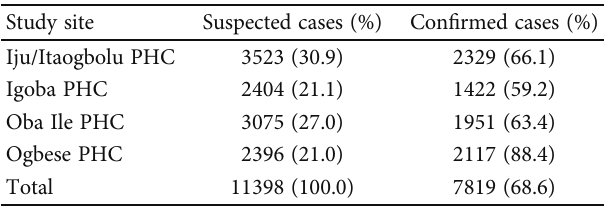
Figure 3: Percentage infection of malaria and COVID-19 in relation to the age group in Akure North Local Government Area of Ondo State, Nigeria. Table 4: Prevalence of malaria infection in di ff erent towns in North LGA of Ondo State,